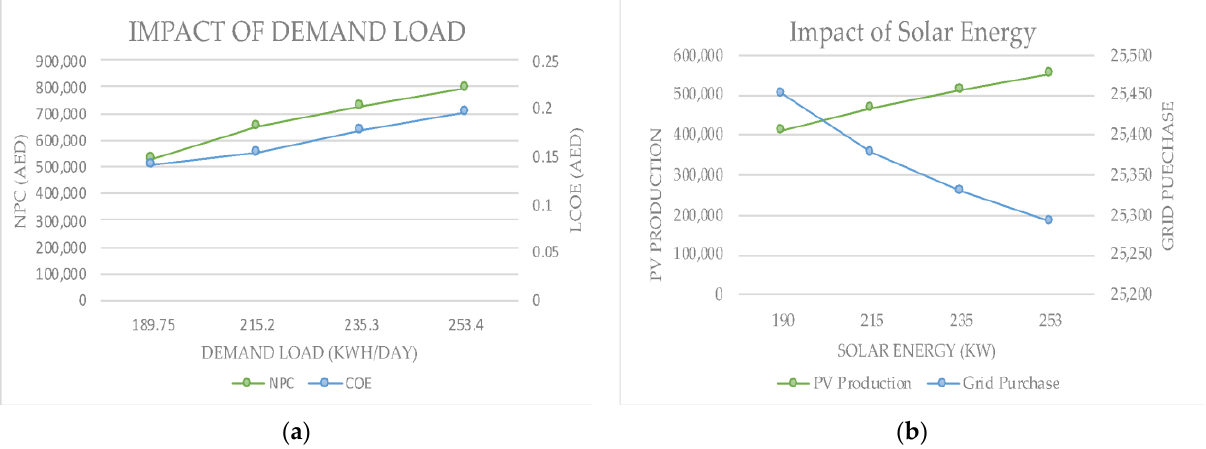
Figure 9. ( a ) Impact of Demand Load (kWh/day). ( b ) Impact of Solar Energy (kW).